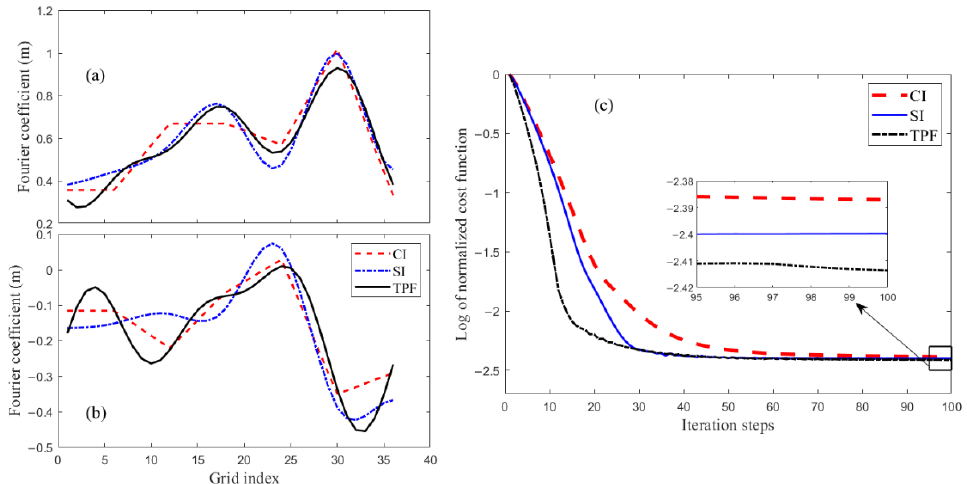
Figure 12. FCs α ( a ) and β ( b ) and the descent process with iteration steps for the normalized cost function ( c ) inverted by different approaches.